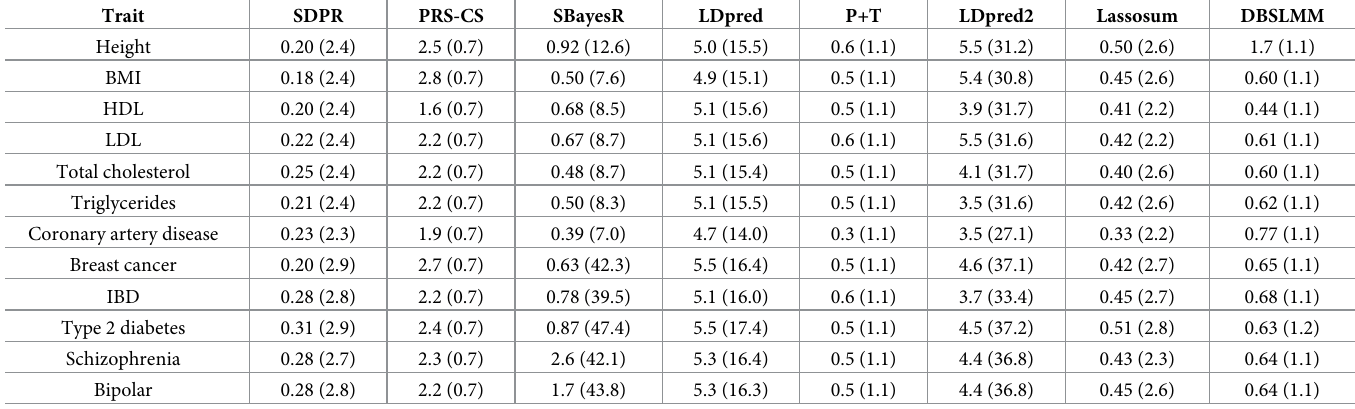
Table 2. Computational time and memory usage of different methods for 12 traits. The computational time is in hours. Memory usage of each method, as listed in the parenthesis, is measured in the unit of Gigabytes (Gb). We did not include the time of computing PRS in the validation and test datasets except for P+T, lassosum, LDpred2, and DBSLMM, because such computation was non-trivial for methods with a large grid of tuning parameters.